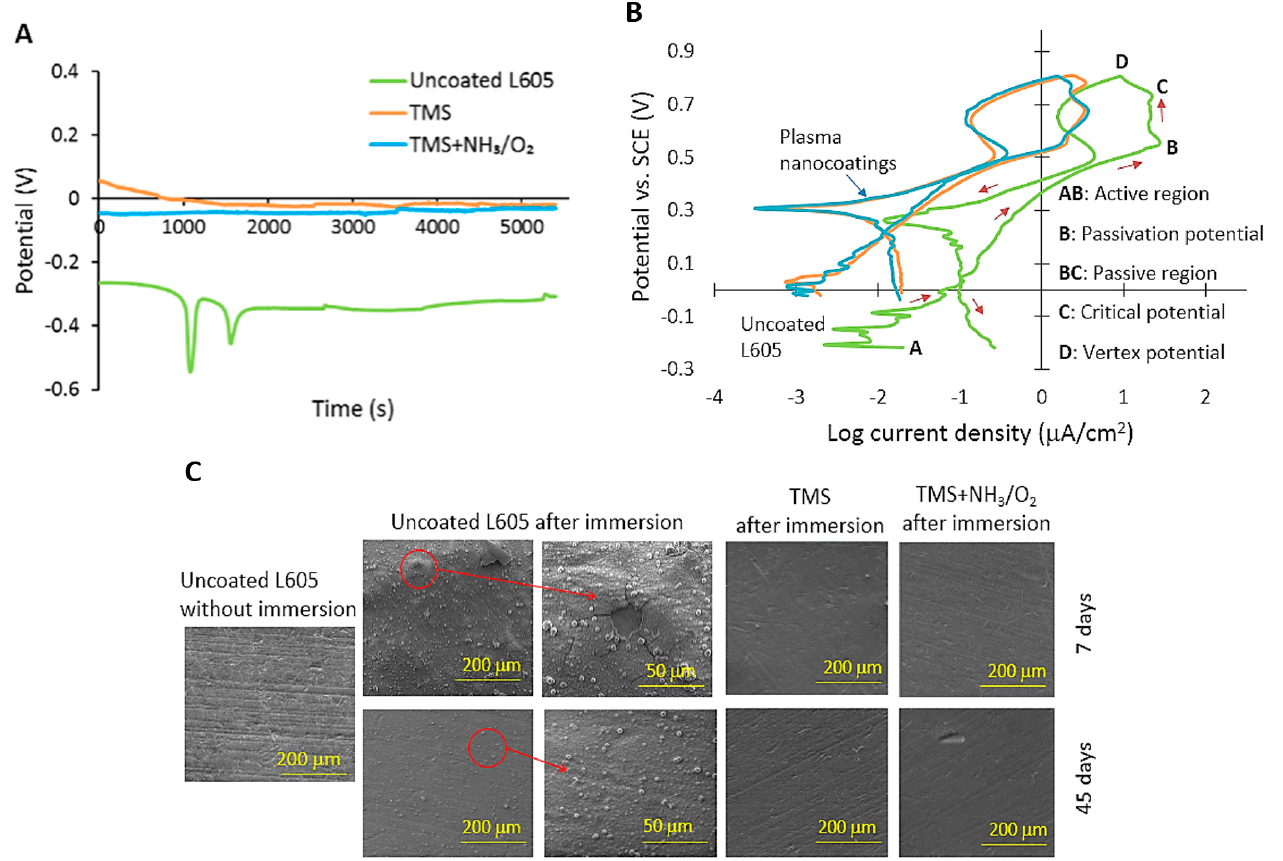
Figure 4. ( A ) Open circuit potential with immersion time for uncoated, TMS, and TMS+NH 3 /O 2 plasma-nanocoated L605 coupon substrates. ( B ) Cyclic polarization curves for uncoated, TMS, and TMS+NH 3 /O 2 plasma-nanocoated L605 coupon substrates. ( C ) SEM images for surface morphology of uncoated and plasma-nanocoated L605 coupons after immersion test. TMS stands for TMS plasma-nanocoated L605, and TMS+NH 3 /O 2 stands for TMS plasma-nanocoated L605 with NH 3 /O 2 plasma post-treatment.